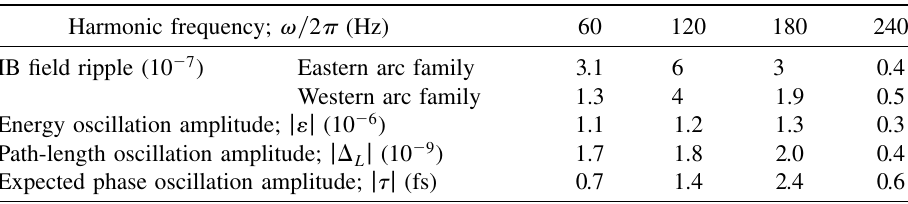
TABLE II. Field oscillation and longitudinal oscillation amplitudes estimated from the orbit oscillation.